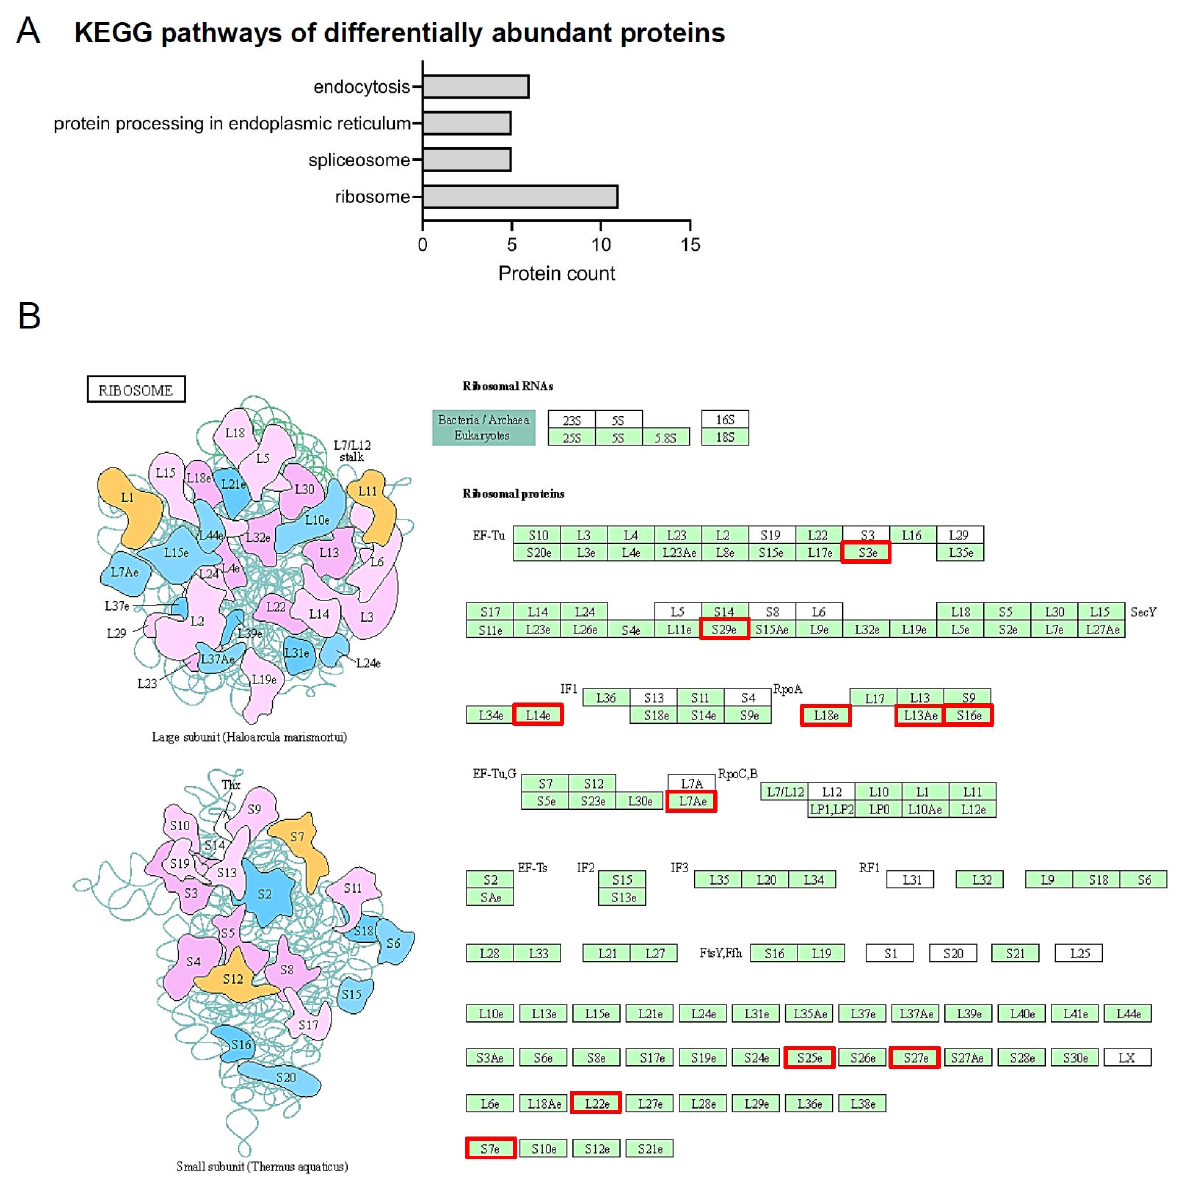
Figure 4. Analysis of all differentially abundant proteins in the PDL of the control and obese groups. ( A ) KEGG pathways of differentially abundant proteins and the number of proteins of each KEGG pathway term. ( B ) Ribosomal pathway information generated by DAVID software. Red squares represent the eleven ribosomal proteins that were more abundant in the control group compared to the obesity group.